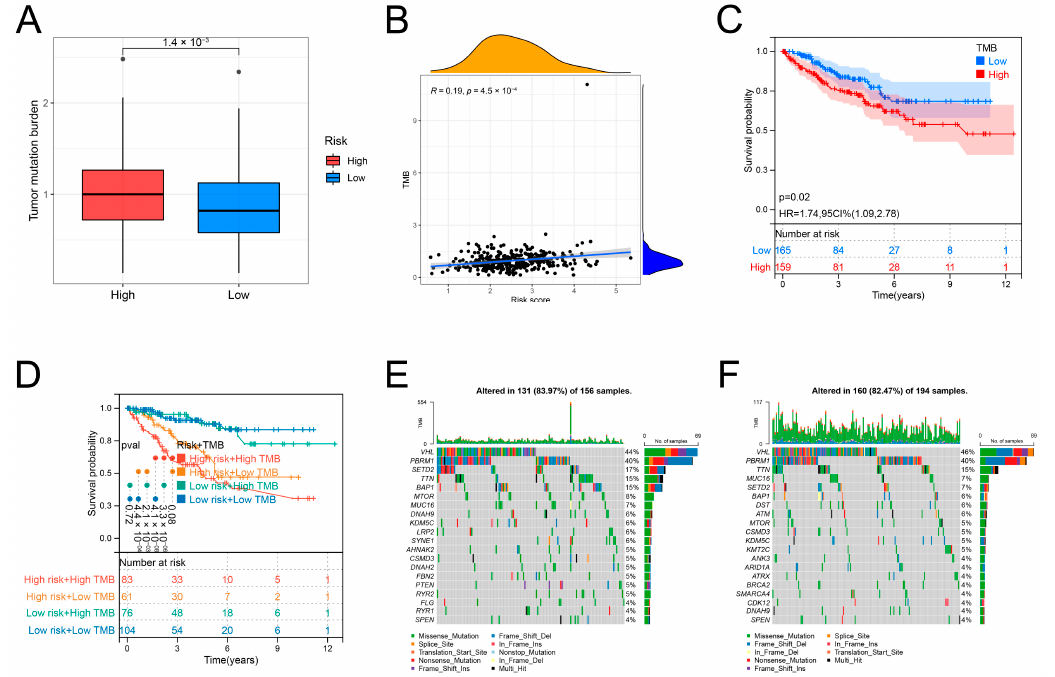
Figure 9. SNV signatures in the two risk groups. ( A ) TMB of both groups of risk. ( B ) Correlation of the TMB with the risk score. ( C ) OS of ccRCC specimens stratified using TMB. ( D ) OS of ccRCC specimens stratified by TMB and the risk score combination. ( E ) Tumor somatic mutation in the group with high risk. ( F ) Tumor somatic mutation in the group with low risk.